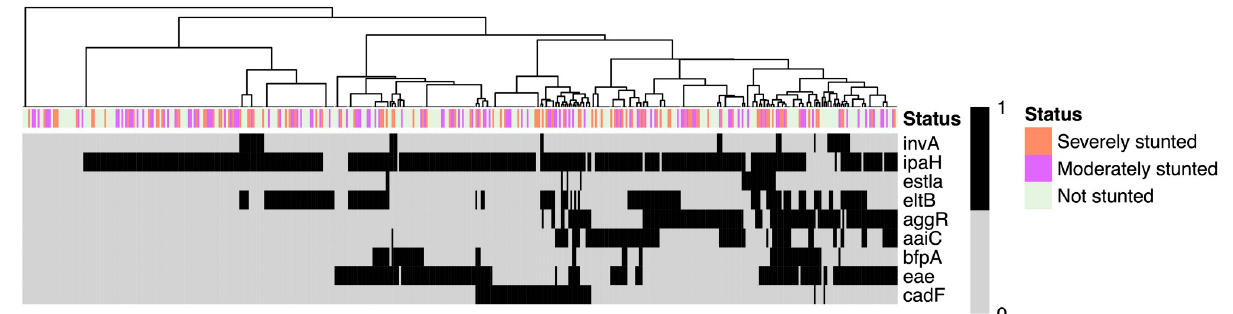
Fig 4. Heatmap showing gene frequency detected by qPCR and height for age Z (HAZ) scores (x-axis: isolates; y-axis: targeted genes). The dendrogram fitted on the isolates (i.e. the subjects) were computed based on an asymmetric binary distance coupled with a Ward agglomeration method based on the presence—black color—or absence of the genes—gray color. The clusters derived from the hierarchical clustering were not shown to be significantly associated to HAZ. No clustering was performed on the variables (targeted